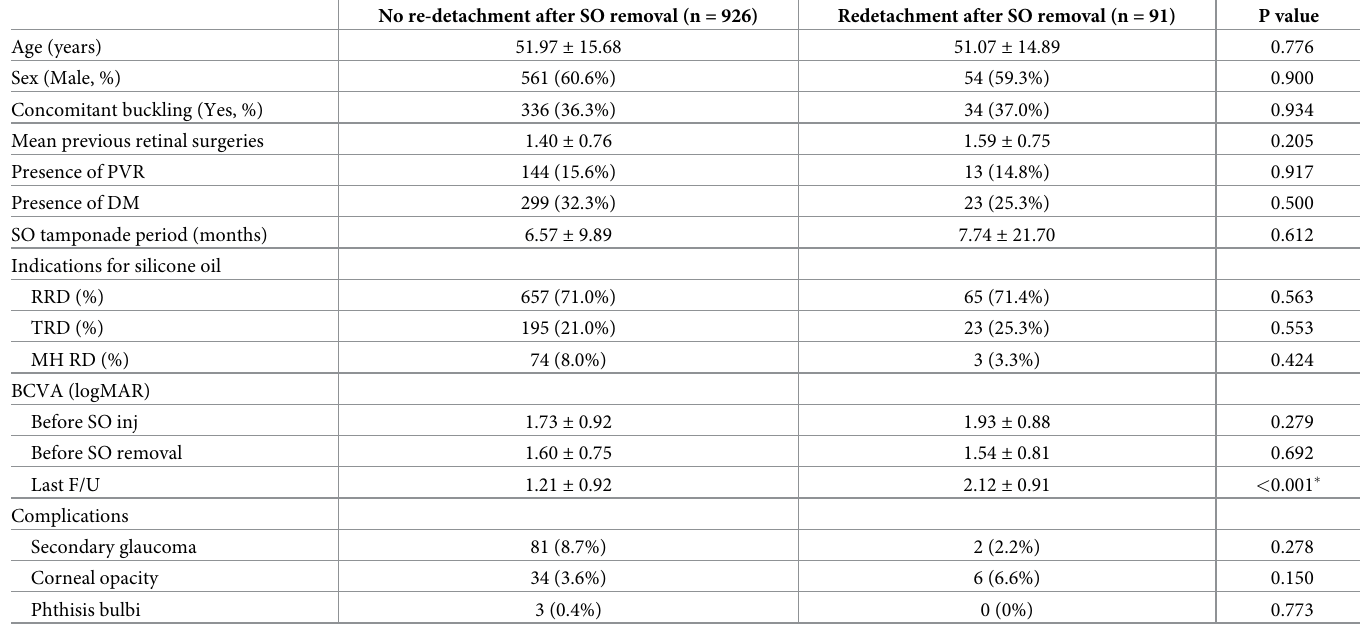
Table 2. Analysis of anatomic outcomes.